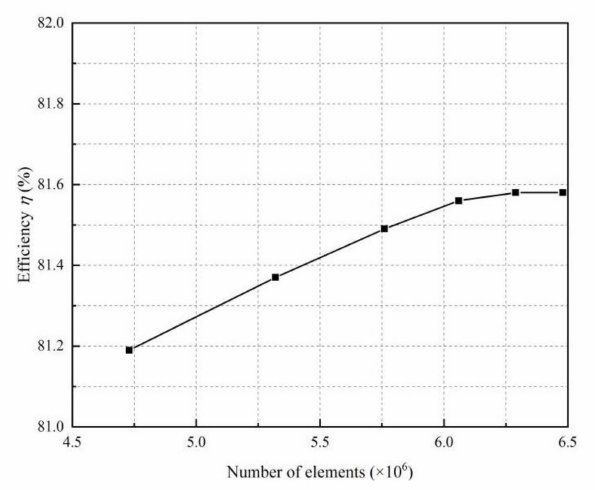
Figure 3. Grid independence